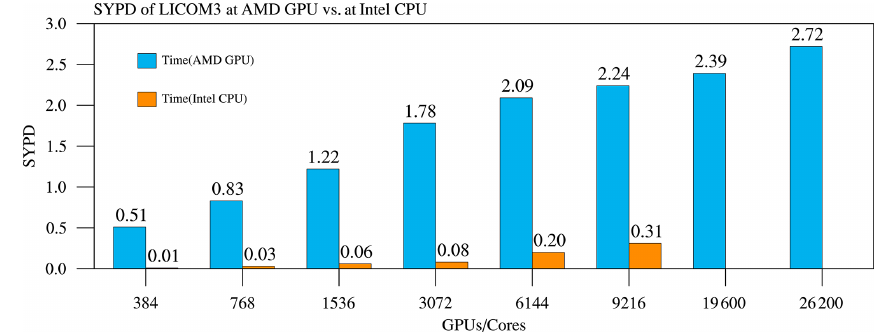
Figure 10. Simulation performances of the AMD GPU vs. Intel CPU core for LICOM3 (1 / 20 ◦ ). Unit: SYPD.